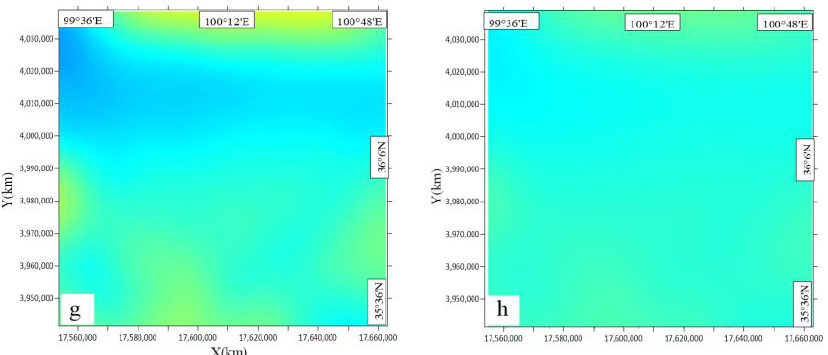
Figure 6. Schematic diagram of different depth horizontal slices of 3-D gravity inversion results ( a ) 2 km; ( b ) 5 km; ( c ) 8 km; ( d ) 10 km; ( e ) 15 km; ( f ) 20 km; ( g ) 25 km; ( h ) 30 km.